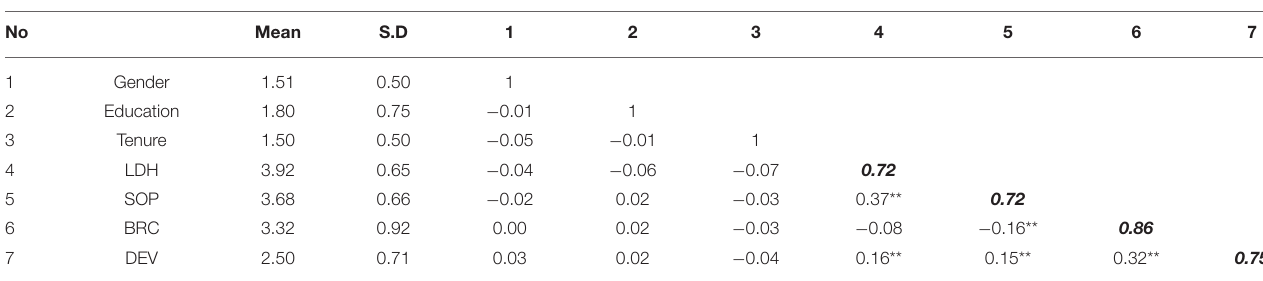
TABLE 2 | Descriptive statistics and correlations of the study